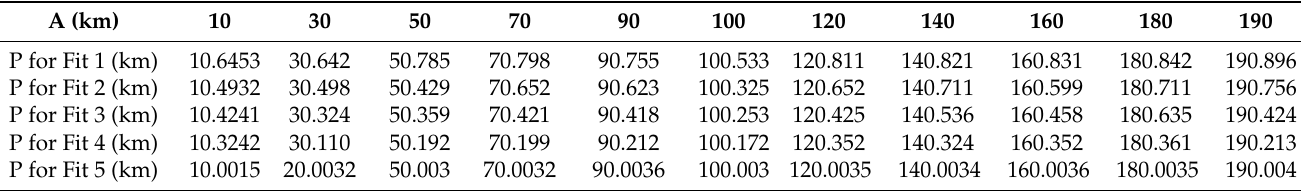
Table 13. Actual (A in km) and predicted (P in km) fault locations under LLL-G fault scenario.